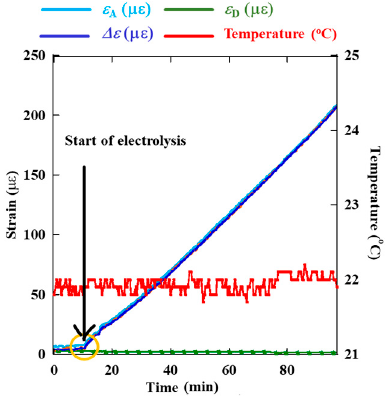
Figure 9. Strain signal pattern as a function of elapsed time during electrolysis process.